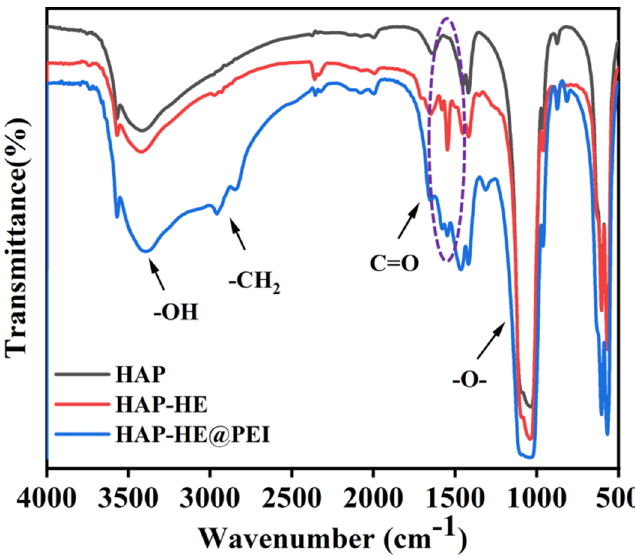
Figure 4. Normalized FT − IR spectra of HAP, HAP − HE and HAP − HE@PEI.